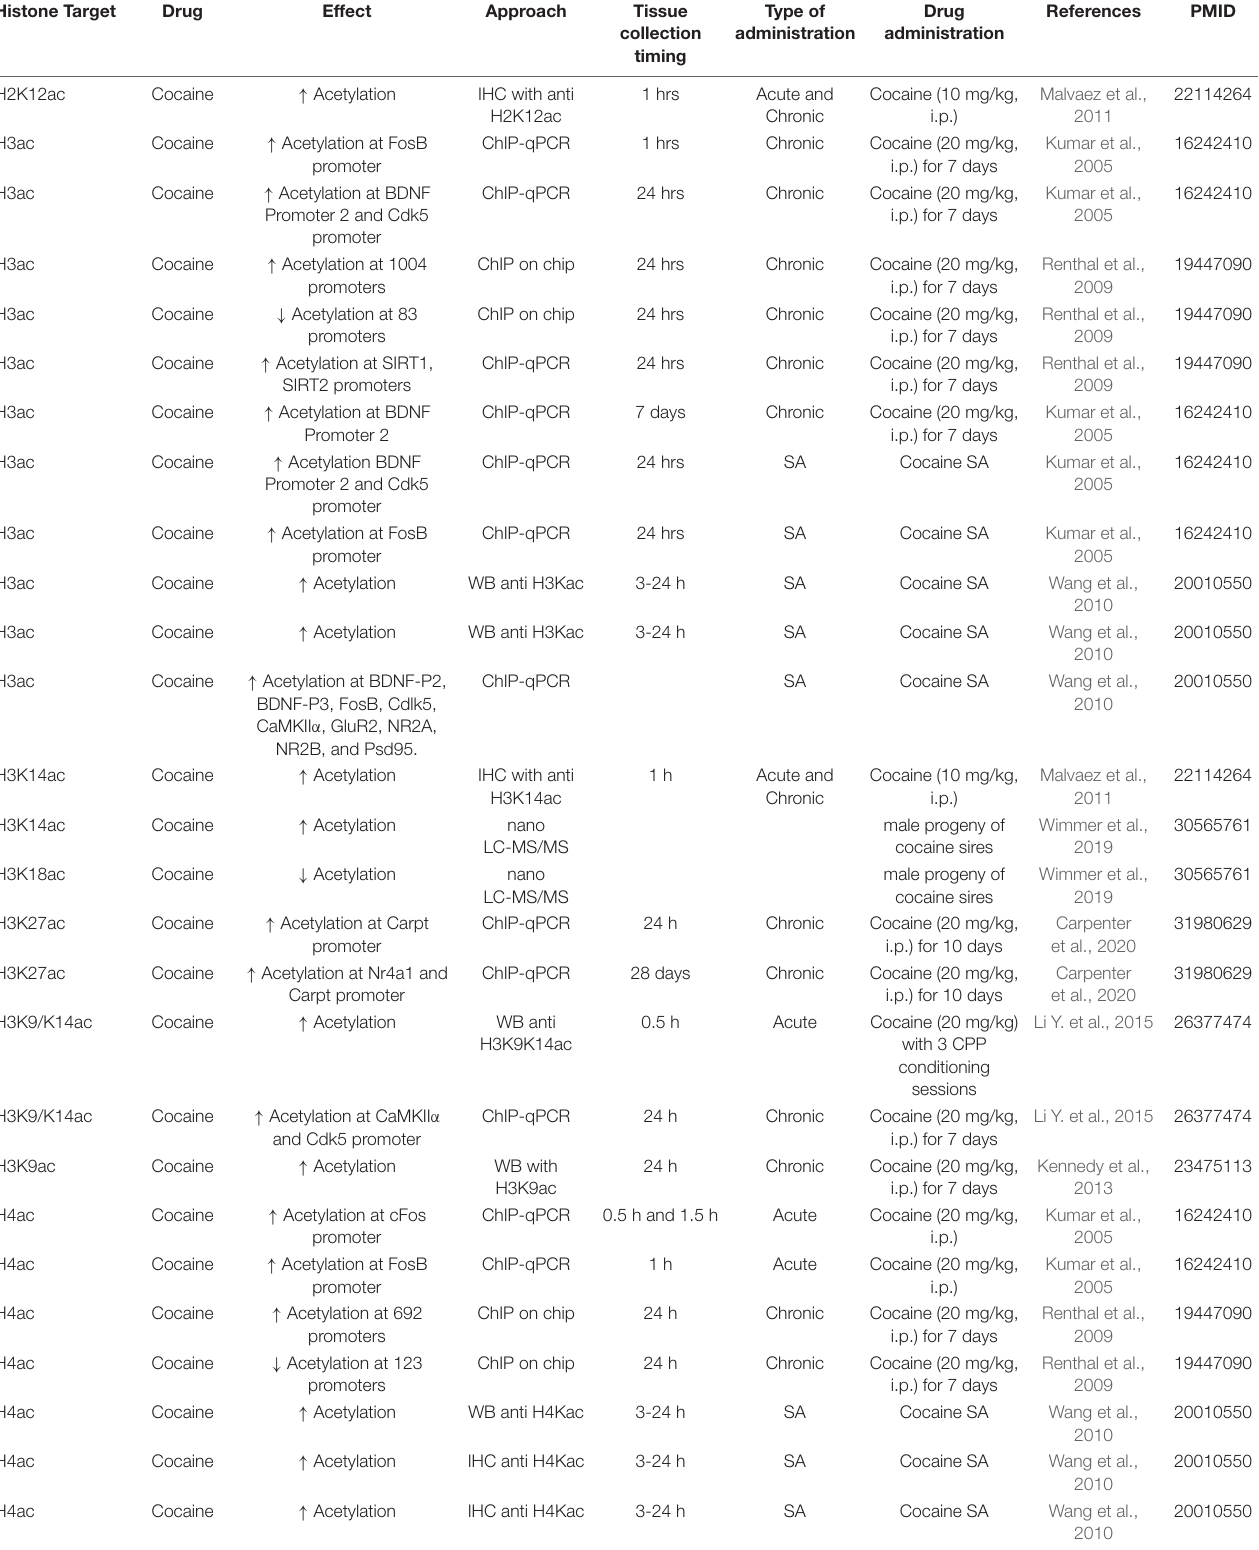
TABLE 1 | Effects of drug exposure on histone acetylation. Histone